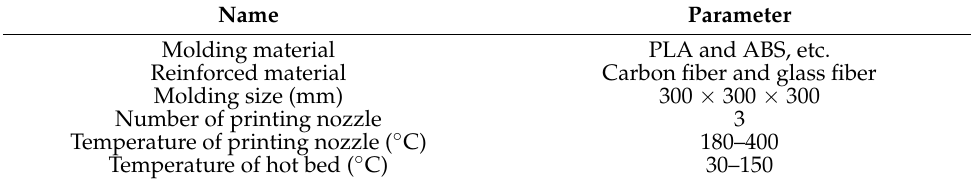
Figure 2. ( a ) Self-made 3D printer of CFRC. ( b ) Working principle of the printing heads. ( c ) Printing head of CFRF. Table 1. Machine parameters of the 3D printer.